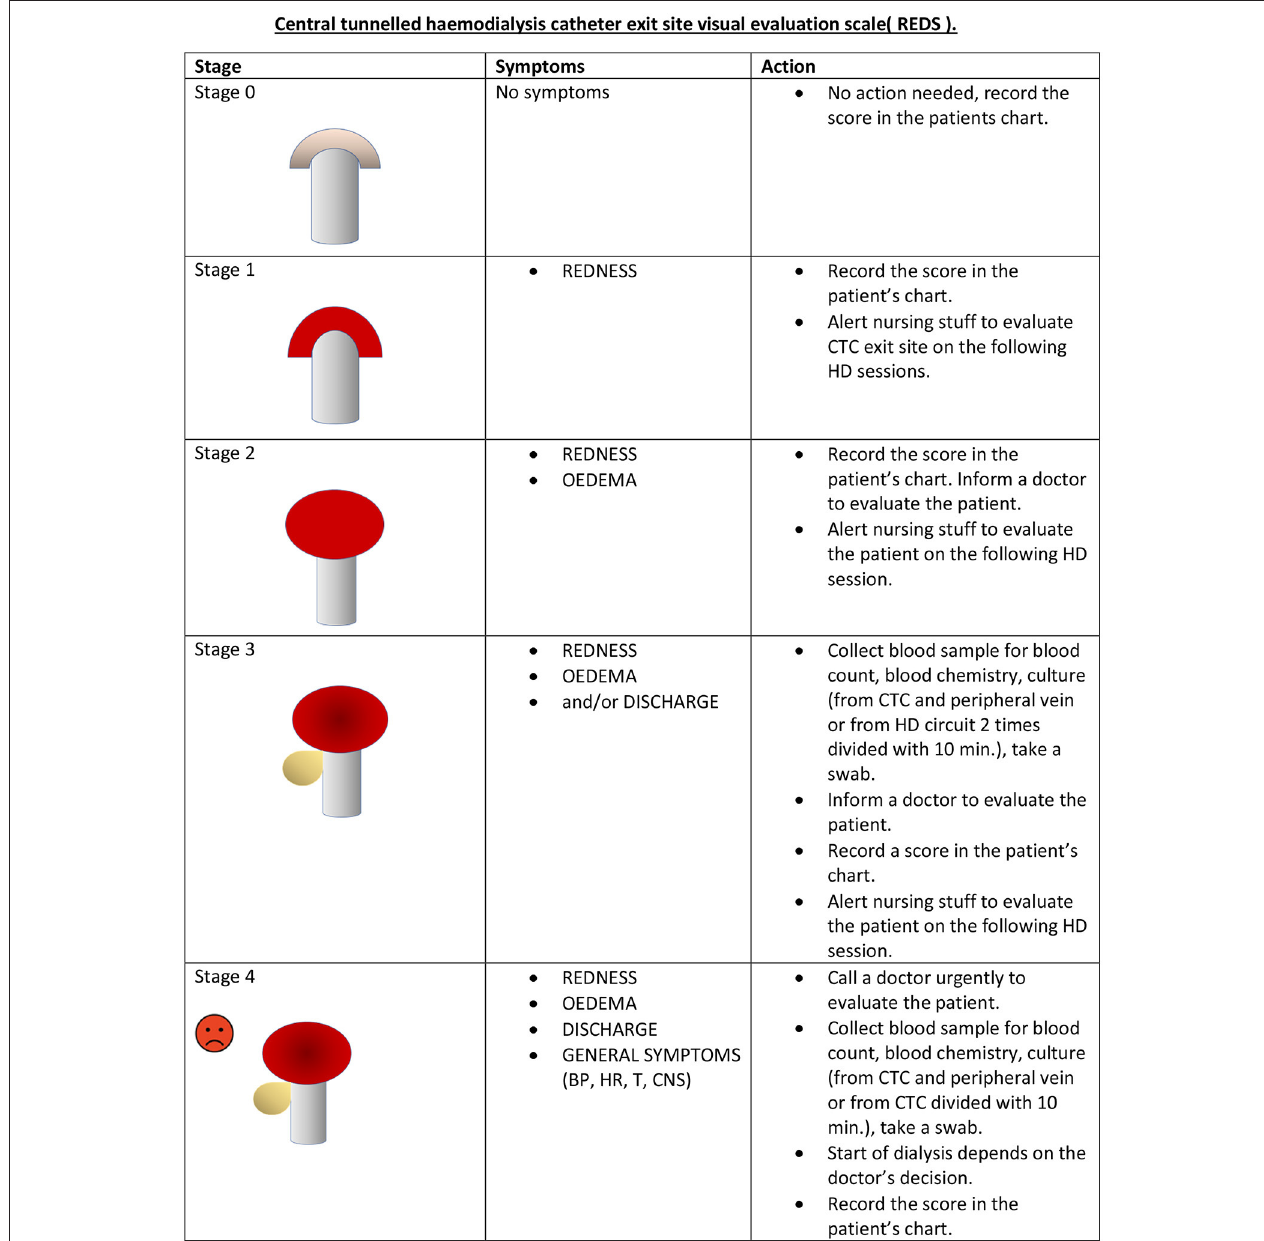
FIGURE 1 | REDS scale chart